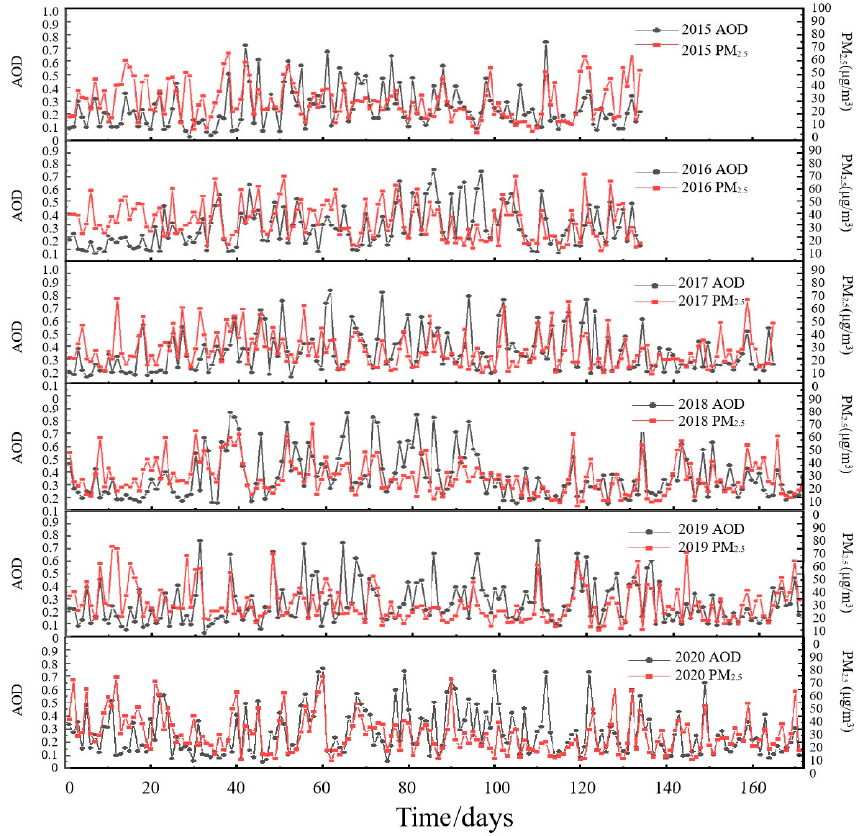
Figure 5. Time series of AOD and PM 2.5 from 2015 to 2020.